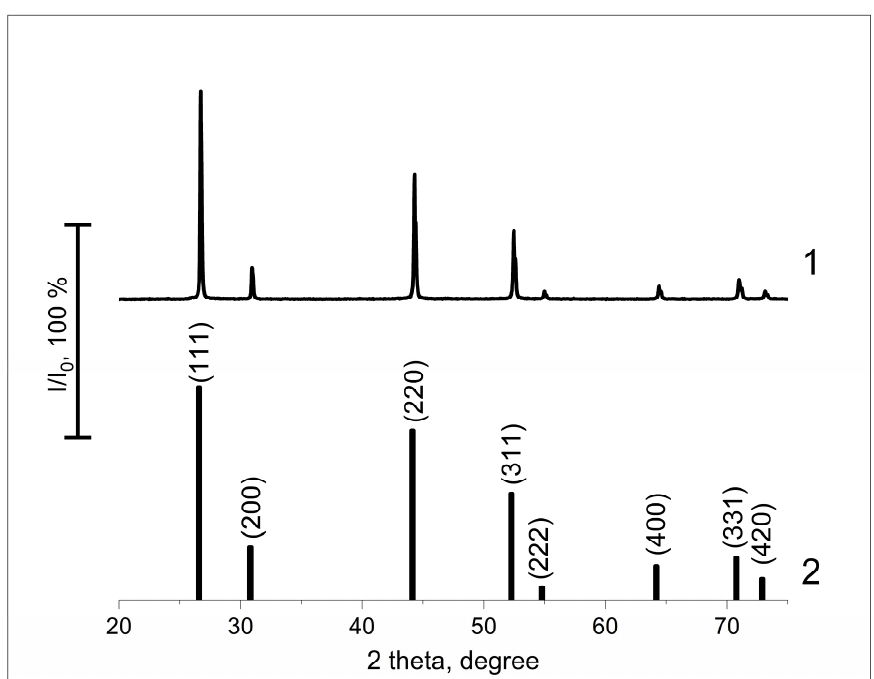
Figure 1. XRD for the Sr 0.955 Yb 0.020 Er 0.025 F 2.045 nanoparticles ( 1 ) and JCPDS #06-0262 for the strontium fluoride ( 2 ). The scanning electron microscopy image for Sr 0.955 Yb 0.020 Er 0.025 F 2.045 samples shown in Figure 2A made it possible to determine the shape and diameter of the particles. Two fractions of spherical particle were identified: primary particles were approximately 75 nm, and agglomerates with a 300 nm diameter. The dynamic light scattering method con- firmed the formation of both primary particles and their agglomerates (Figure 2B). The energy-dispersive X-ray analysis clarified the elemental composition of the particles: Sr 0.948 Yb 0.024 Er 0.028 F 2.052 .